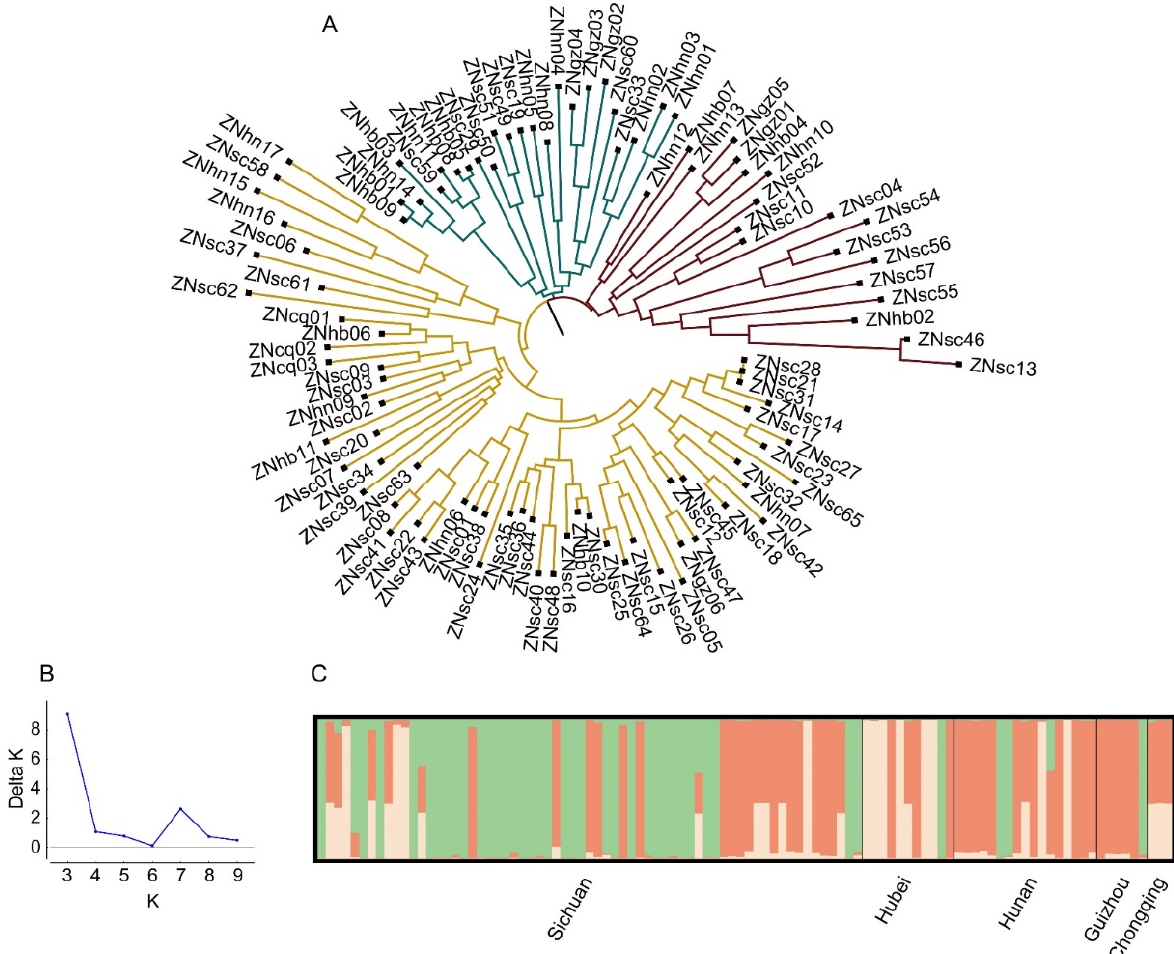
Figure 1. Phylogenetic and population structure analysis of 102 germplasms. ( A ) Phylogenetic tree of 102 germplasms based on genetic distance. The different colors represent three different groups (claret, dark blue and yellow group) of the whole germplasms which was divided by genetic distance among germplasms. ( B ) Delta K based on the rate of change of L(K) between successive K-values. ( C ) Population structure based on K = 3. The different colors represent three different sub-populations (light-green, orange, and light-yellow sub-populations) according to the Q value of STRUCTURE